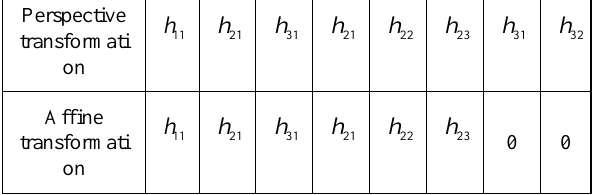
Table 1. Image transformation parameters